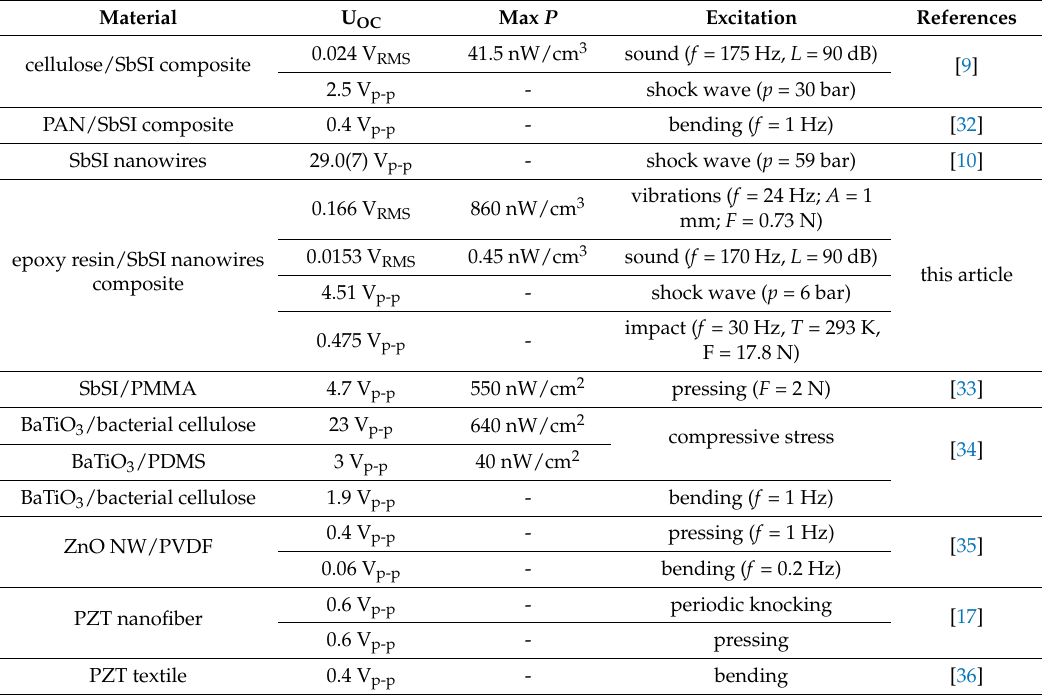
Table 1. Comparison of open-circuit voltages and power densities registered for different types of materials, consisting of SbSI, BaTiO 3 , ZnO, and